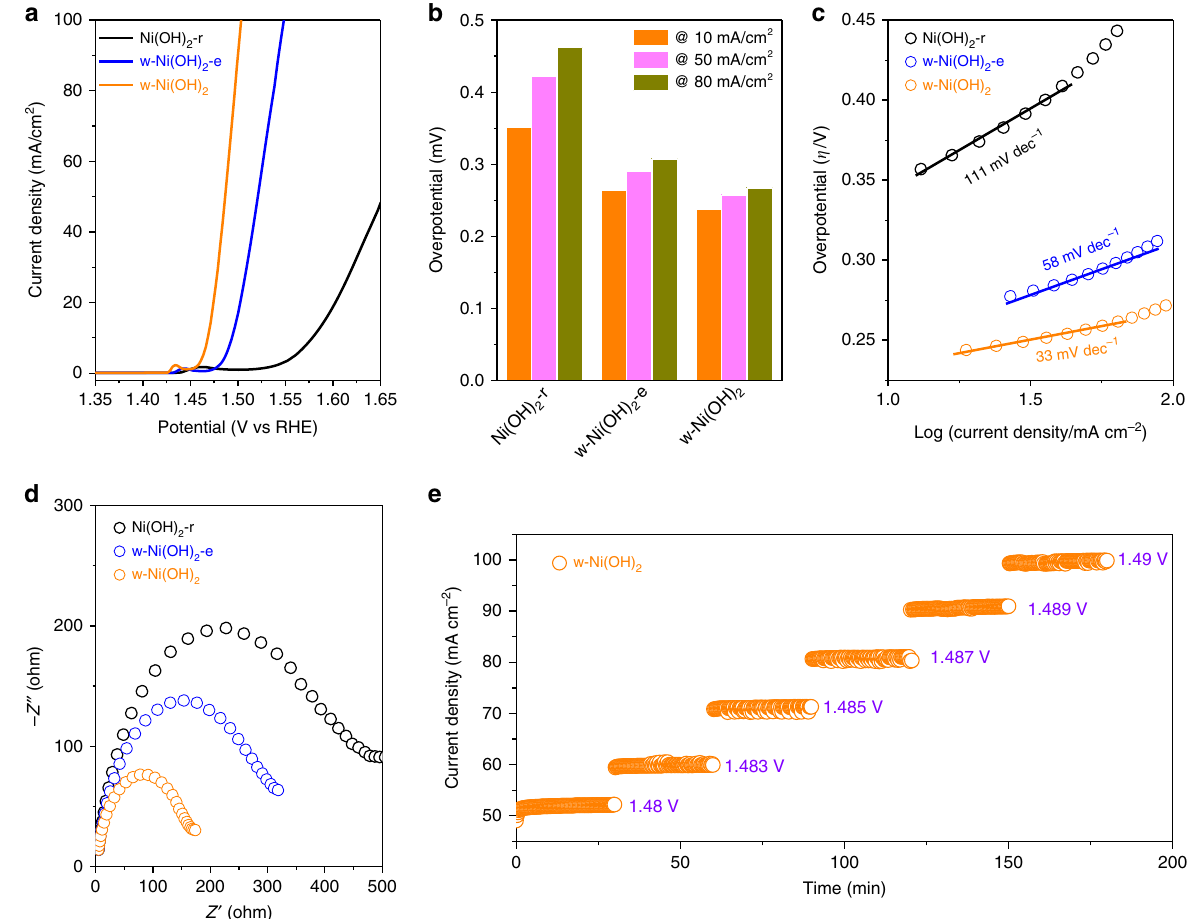
Fig. 4 Electrocatalytic water oxidation performance. a 95% iR-corrected polarization curves of reference Ni(OH) 2 -r, w-Ni(OH) 2 -e, and w-Ni(OH) 2 samples. b The overpotentials required for j = 10, 50, 80 mA cm − 2 with different electrodes. c Tafel plots for Ni(OH) 2 -r, w-Ni(OH) 2 -e, and w-Ni(OH) 2 electrodes. d EIS Nyquist plots of the Ni(OH) 2 -r, w-Ni(OH) 2 -e, and w-Ni(OH) 2 electrodes under the bias potential of 1.48 V. e Chronopotentiometric measurements of OER at various current densities using w-Ni(OH) 2 as a catalyst. All the tests were carried out in 1 M KOH solution (O 2